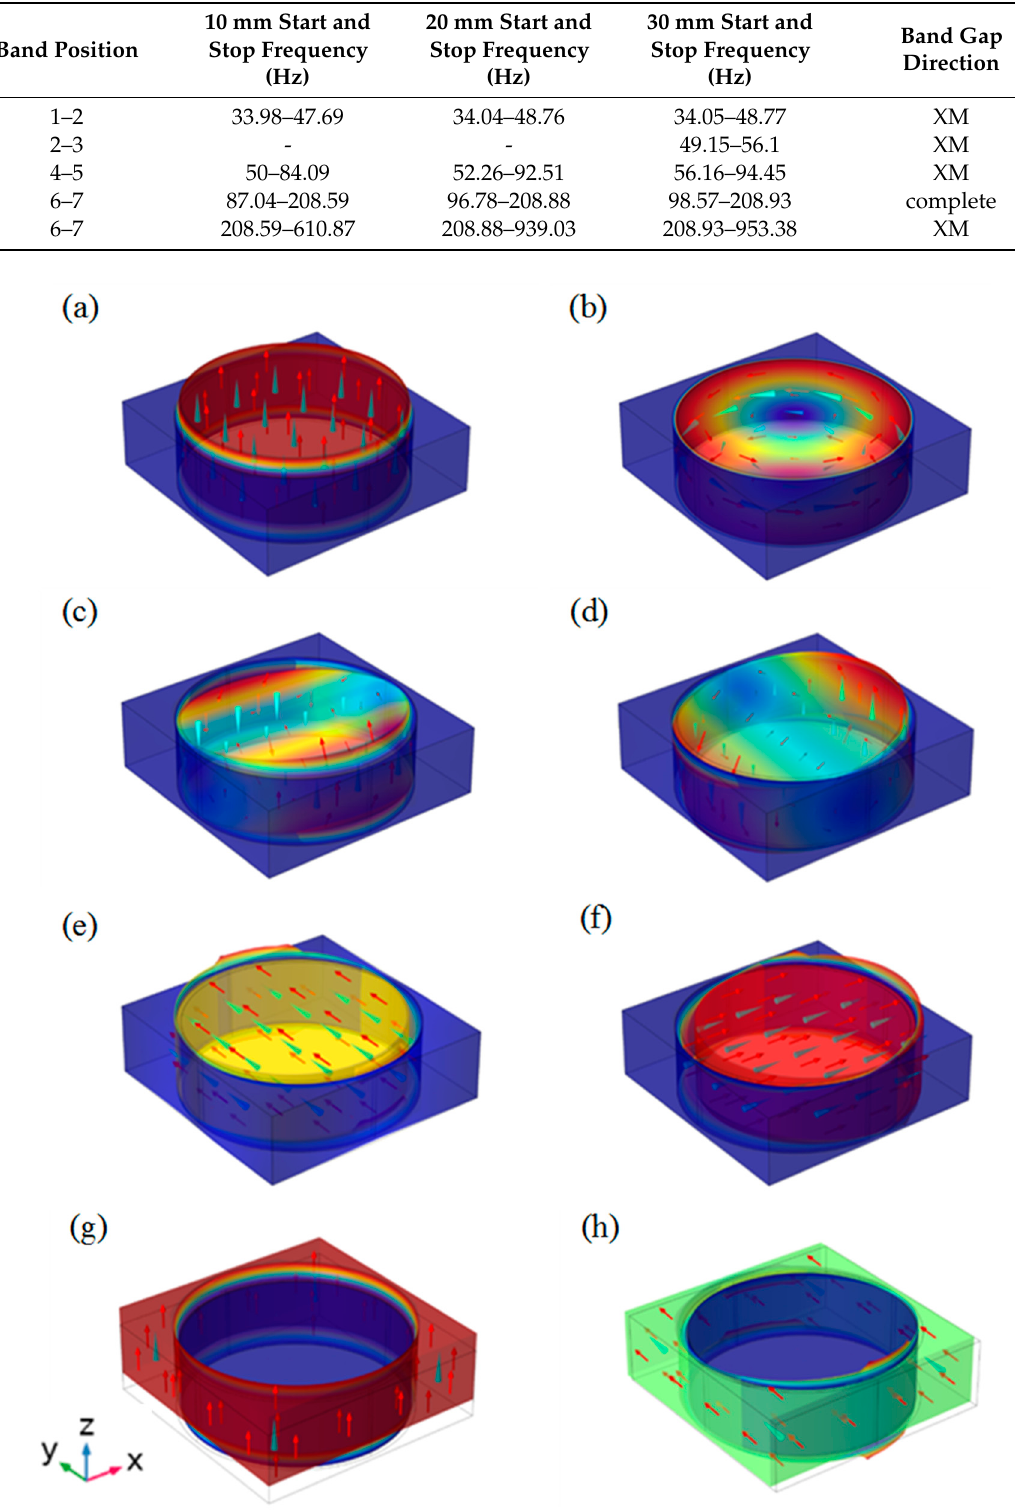
Figure 5. Modal diagram: ( a ) first band, ( b ) second band ( c ) third band ( d ) fourth band, ( e ) fifth band, ( f ) sixth band, ( g ) lower edge of seventh band, ( h ) lower edge of seventh band in the X–M direction.